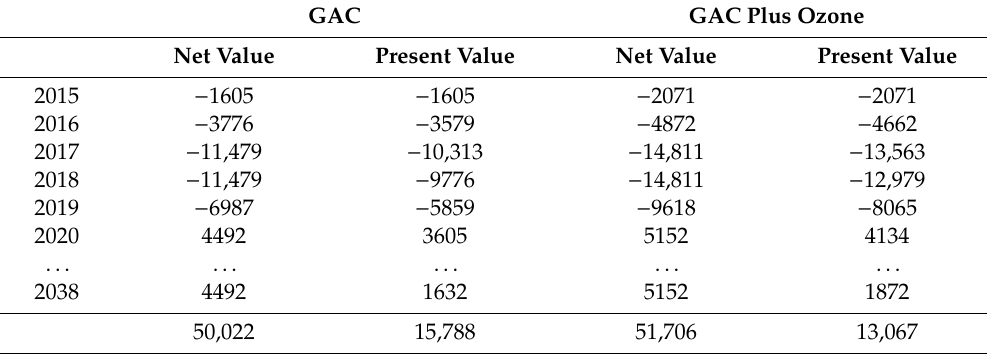
Table 11. Cash flows of the GAC and GAC plus ozone alternatives (summarizing cost and benefit flows). GAC GAC Plus Ozone Net Value Present Value Net Value Present Value 2015 − 1605 − 1605 − 2071 − 2071 − 3579 − 4872 − 4662 − 10,313 − 14,811